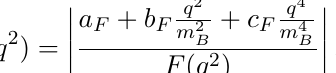
; A ; A ; T ; T ; T g 1 2 0 1 2 3